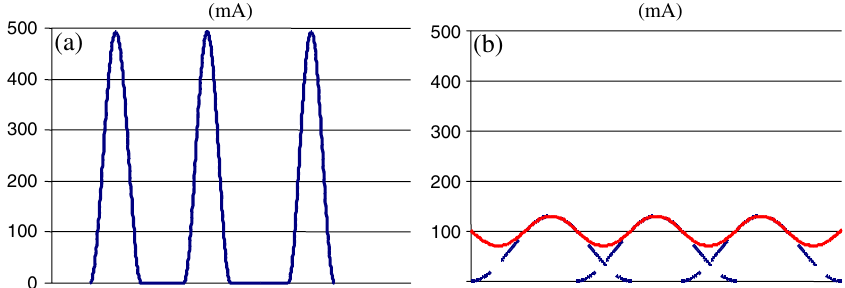
FIG. 8. (Color) (a) The MATHEMATICA simulation of the IPHI beam current versus time, the beam is bunched, the mean current is 100 mA. (b) In the dashed curve, the corresponding image signal parts of the bunched beam, seen at the wall, lead to a superposition, while the mean value (DC component) is still 100 mA. The AC components are reduced, the red trace looks like a sine function, and therefore the current out of the button has very few harmonics. TABLE II. The wall current amplitude of the first Fourier harmonic (352.2 MHz) simulated for each BPM and for two bunch distributions. The BPM are designed for a 33 mm chamber radius and the last one for a 75 mm chamber radius. Cosine 2 distribution Gaussian distribution